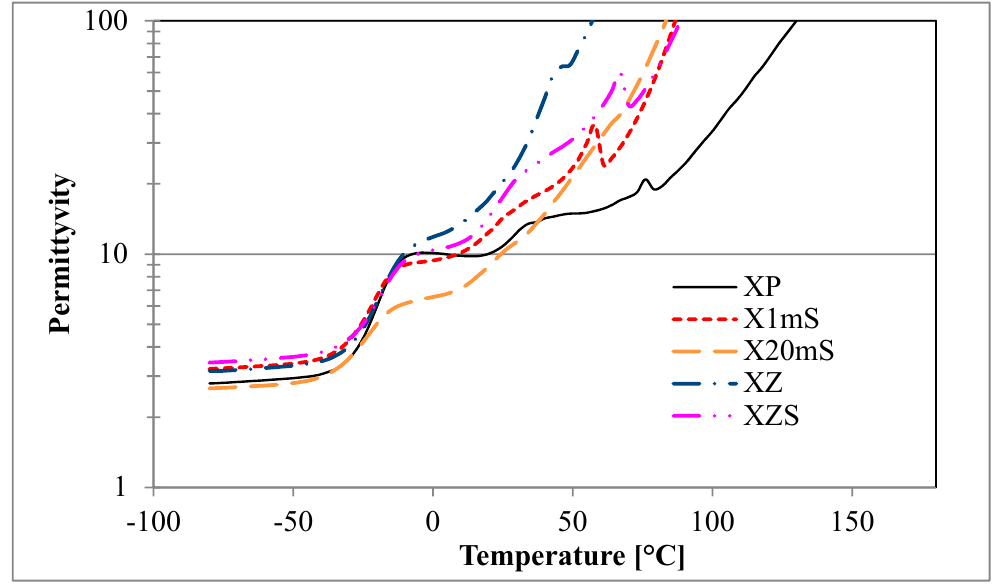
Figure 5. The temperature ( T ) dependency of permittivity ( ε ’ ) at 5 Hz for XNBR vulcanizates.